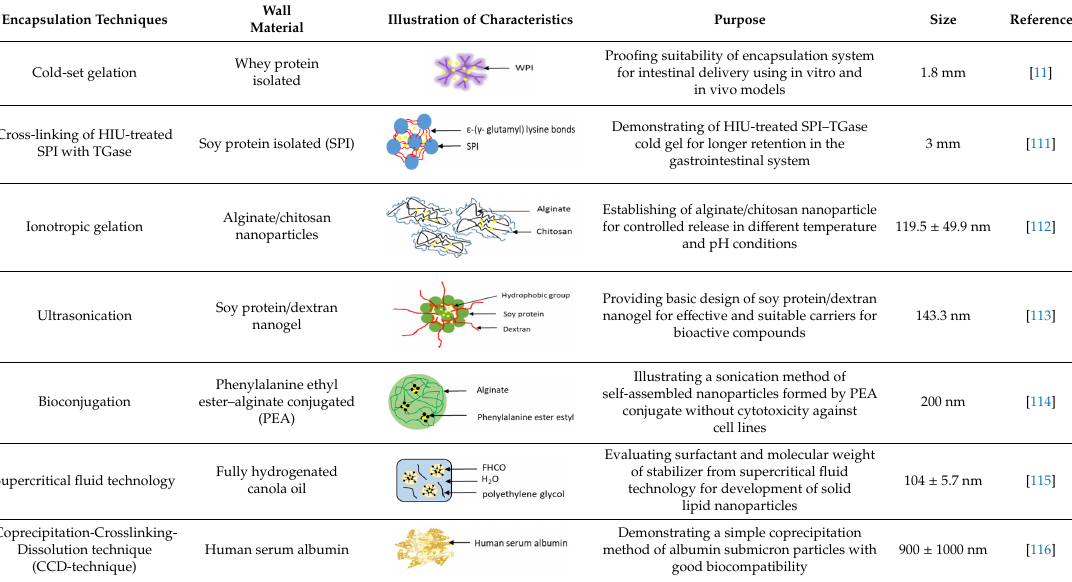
Table 5. Techniques and characteristic of micro/nanoencapsulation of encapsulated RF.